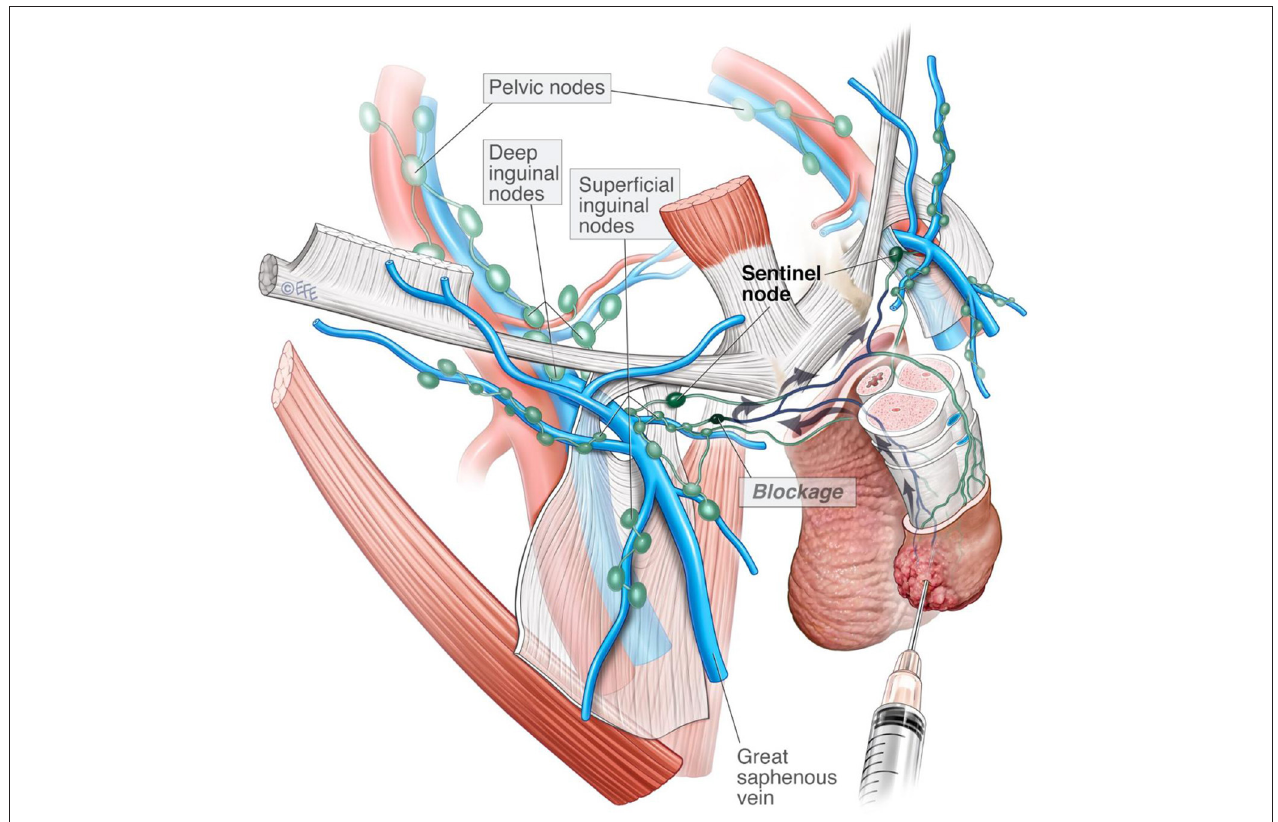
FIGURE 2 | Artistic rendering of re-routed lymphatic drainage.